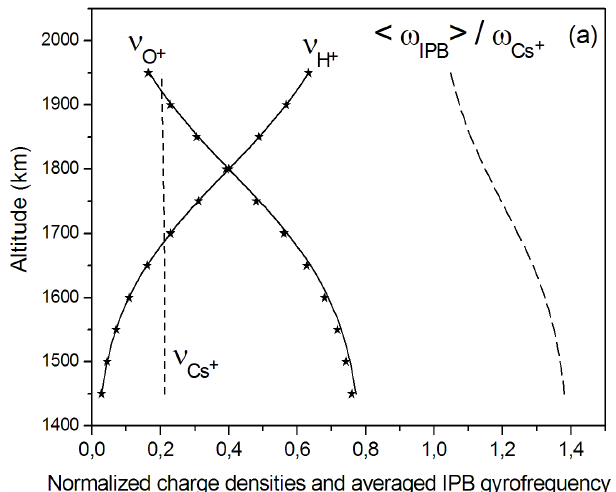
Fig. 1b. ν Cs + = 0 . 5.